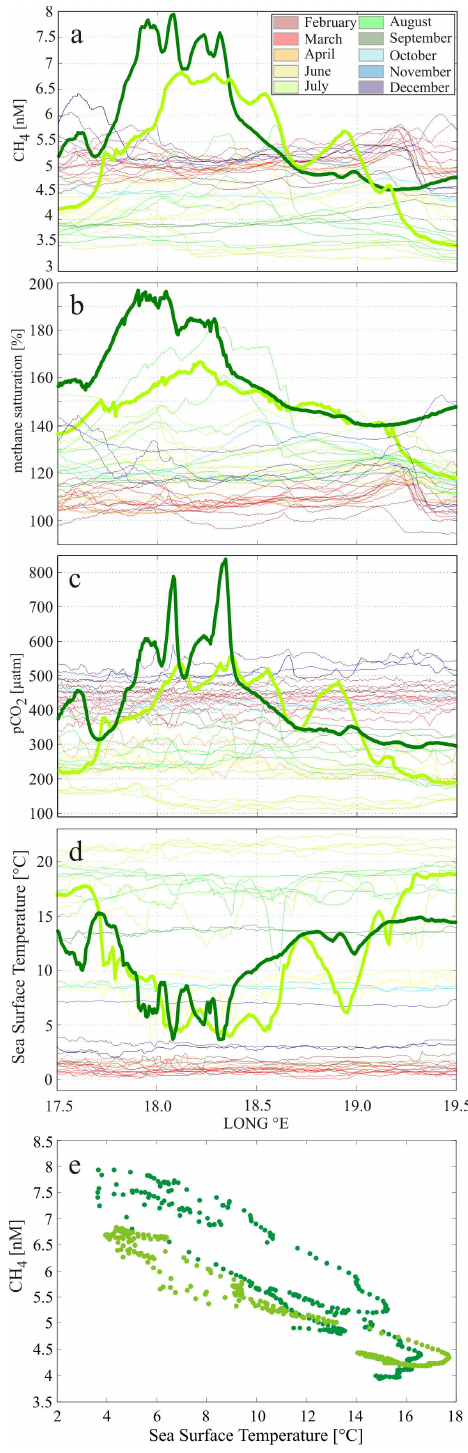
Fig. 3. (a) Methane, (b) methane saturation, (c) carbon dioxide and (d) sea surface temperature of the area West of Gotland for the year 2010. All data in transparent thin lines color coded for each month. Two significant upwelling events in July and September are highlighted with outstanding light green (24 July) and dark green (3 September) lines. For these dates, methane versus sea surface temperature is shown using the same color coding (e)